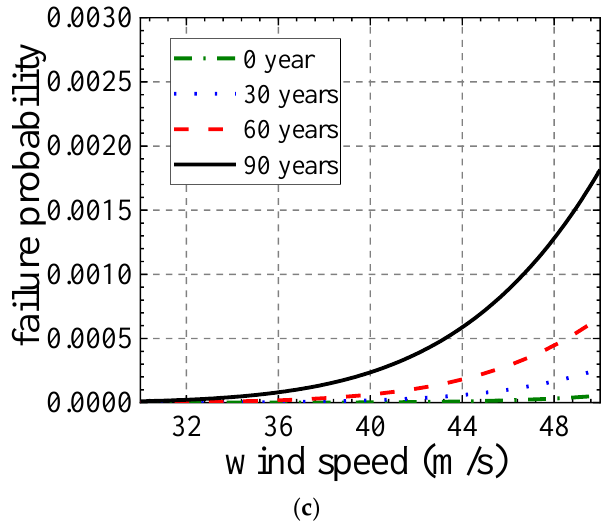
Figure 21. Wind-induced fragility curves of the transmission tower with different corrosion ages under the industrial-marine atmospheric environment in the Ningbo area. ( a ) Minor damage. ( b ) moderate damage and ( c ) severe damage and collapse.